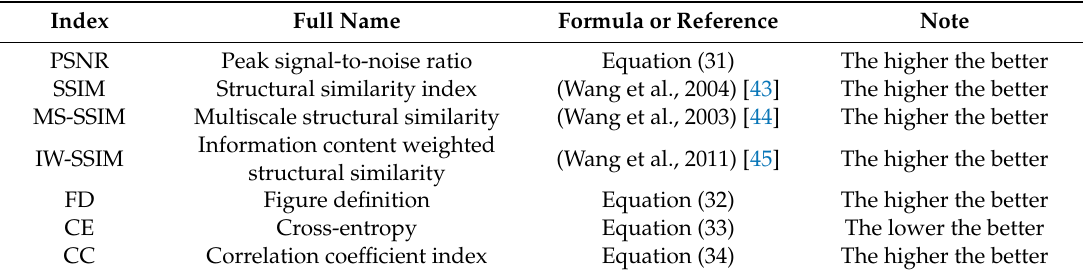
Table 1. The induction of the quantitative metrics used in simulated